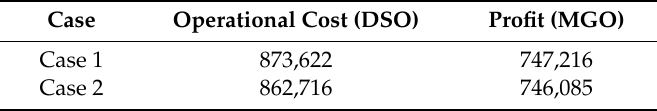
Table 5. Comparison of the optimal results for each